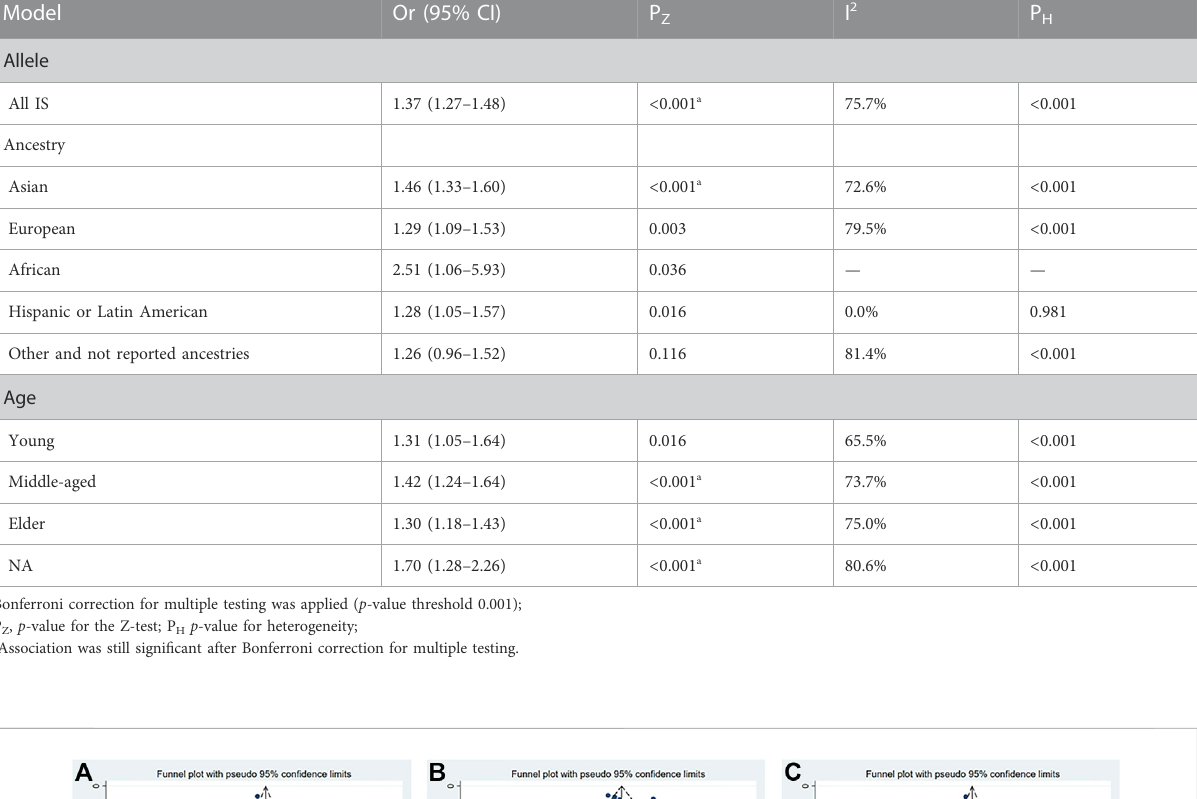
TABLE 6 Pooled odds ratios (ORs) and 95% con fi dence intervals (CIs) of the association between C677T polymorphism and stroke in the allelic model.